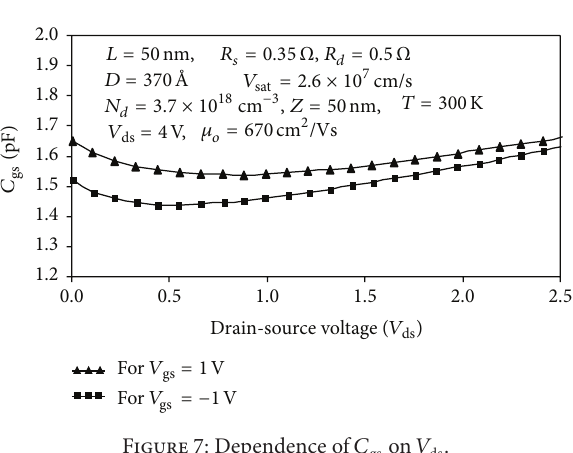
Figure 7: Dependence of 𝐶